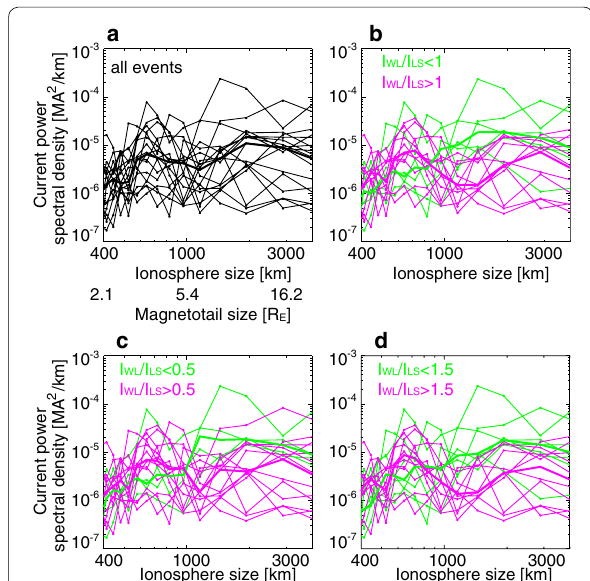
Fig. 4 a Azimuthal spectra of the upward/downward currents integrated over latitude. The dots and thin lines correspond to individual events, and the thick line shows the median. a All events. b Same as Panel a but color-coded with I WL / I LS > 1 (pink) and I WL / I LS < 1 (green). c Same as Panel a but color-coded with I WL / I LS > 0.5 (pink) and I WL / I LS < 0.5 (green). d Same as Panel a but color-coded with I WL / I LS > 1.5 (pink) and I WL / I LS < 1.5 (green). I WL